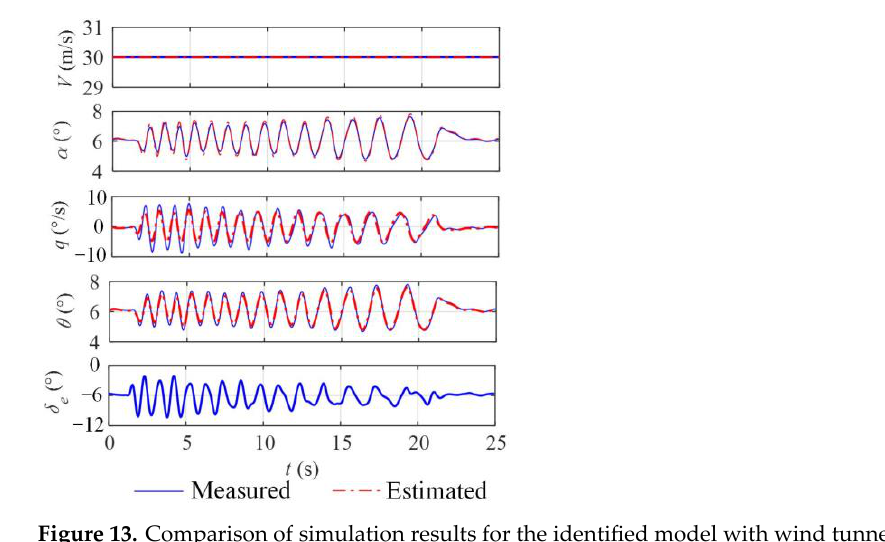
( b ) Figure 12. Comparison of the simulation results of the aerodynamic model obtained by identifica- tion and wind tunnel test data: ( a ) lift; ( b ) drag. Comparison of the identification results with the conventional wind tunnel measure- ments in Table 5 indicates that the identification results of lift and drag derivatives are close to the conventional wind tunnel measurements. Because the strain gauge balance can directly measure the lift and drag of the model, the identification results are equal to the lift and drag derivatives in free flight, thus deviating less from the conventional wind tunnel measurements. 5.2.2. Identification and Correction of the Pitch Moment Derivatives Under the same set of tests, the wind speed V m , pitch angle θ m , pitch rate q m , V-tail